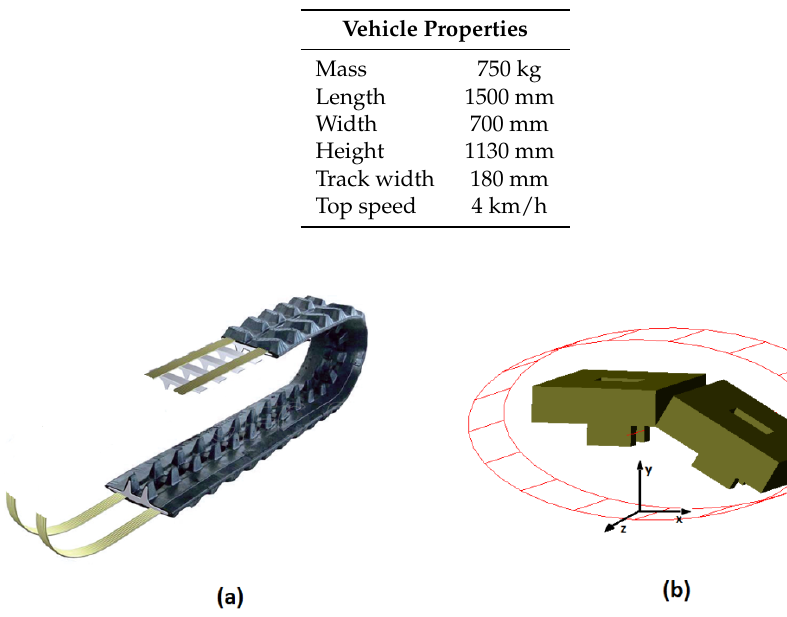
Figure 4. ( a ) Track structure, ( b ) links connected by a bushing